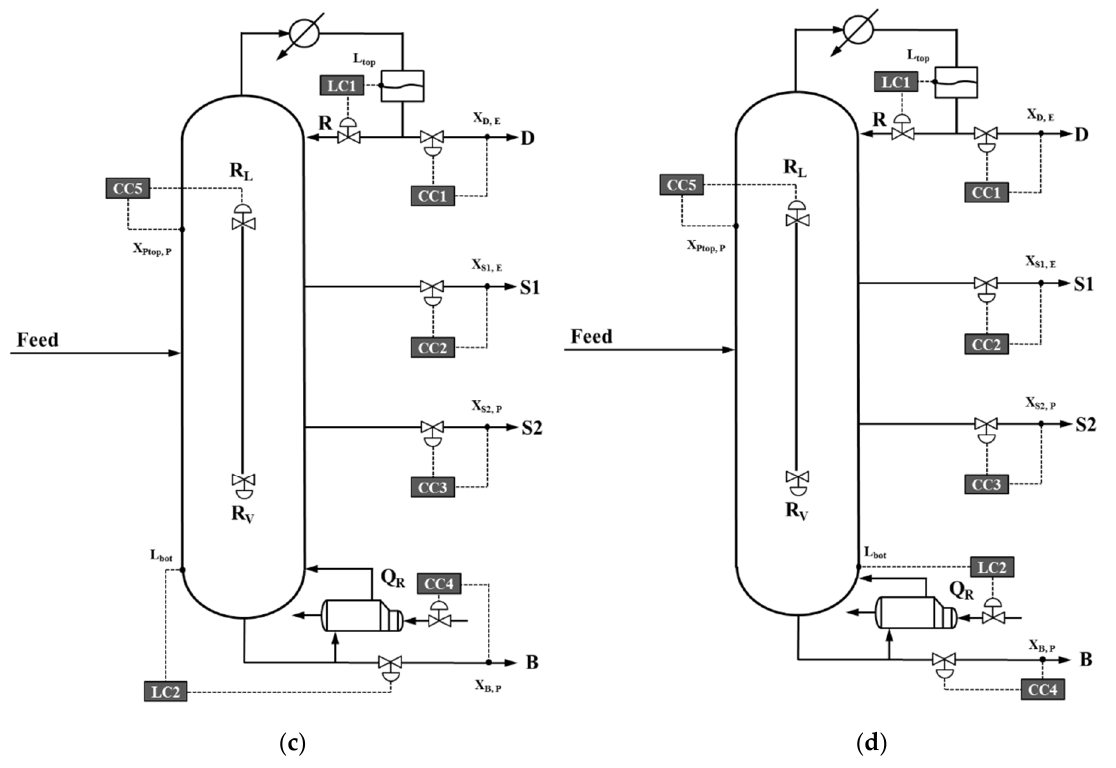
Figure 3. Composition control structures proposed for the control of the Kaibel distillation column: ( a ) CS R/QR structure; ( b ) CS R/B structure; ( c ) CS D/QR structure; ( d ) CS D/B structure.